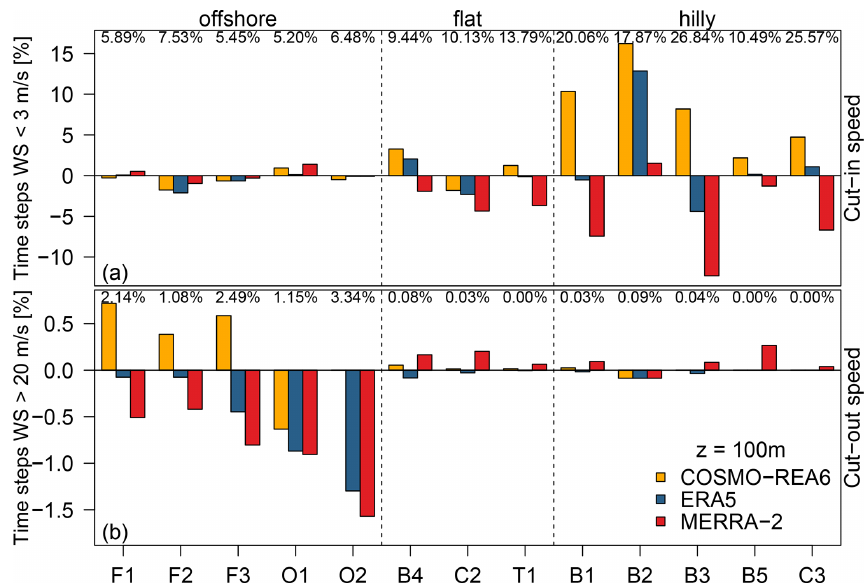
Figure 6. Colored bars represent the difference between the reanalyses COSMO-REA6 (orange), MERRA-2 (red), ERA5 (blue) and the observed percentage of time steps with (a) wind speeds below 3ms − 1 and (b) wind speeds above 20ms − 1 . The observation height is 100m and the sites are grouped into offshore (F1... O2), flat terrain (B4... T1) and hilly regions (B1... C3). The percentages at top of each panel indicate how often the cut-in speed is undercut or the cut-out speed is exceeded in the